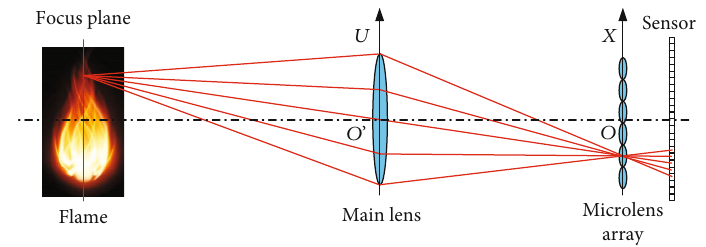
Figure 2: The schematic of a light fi eld